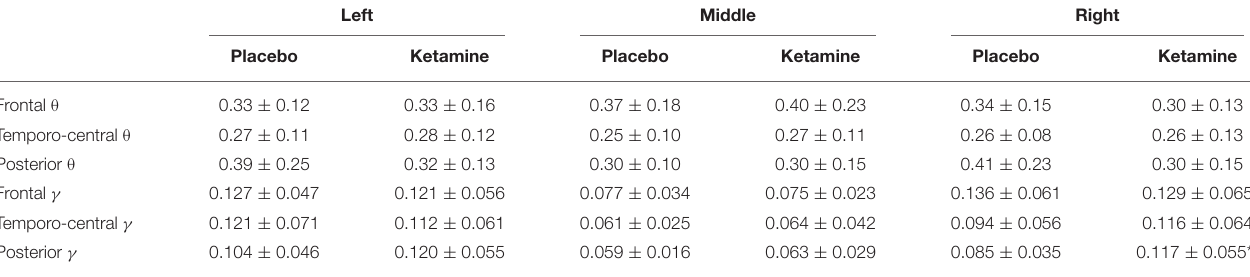
TABLE 2 | Mean CSD (in µ V/m ² ) ( ± SD) in the gamma γ (30–40Hz) and theta θ (4–8Hz) frequency range for different regions, laterality and condition (** p < 0.01). Left Middle Right Placebo Ketamine Placebo Ketamine Placebo